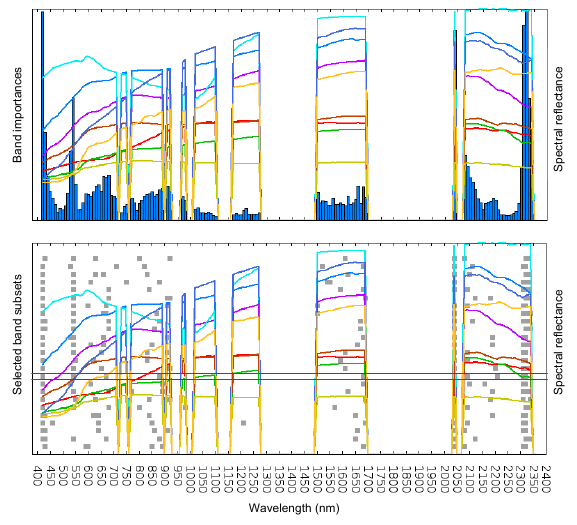
Figure 4: Evolution of the FS score (top) and of the quality of RBF SVM classification depending on the number of selected bands